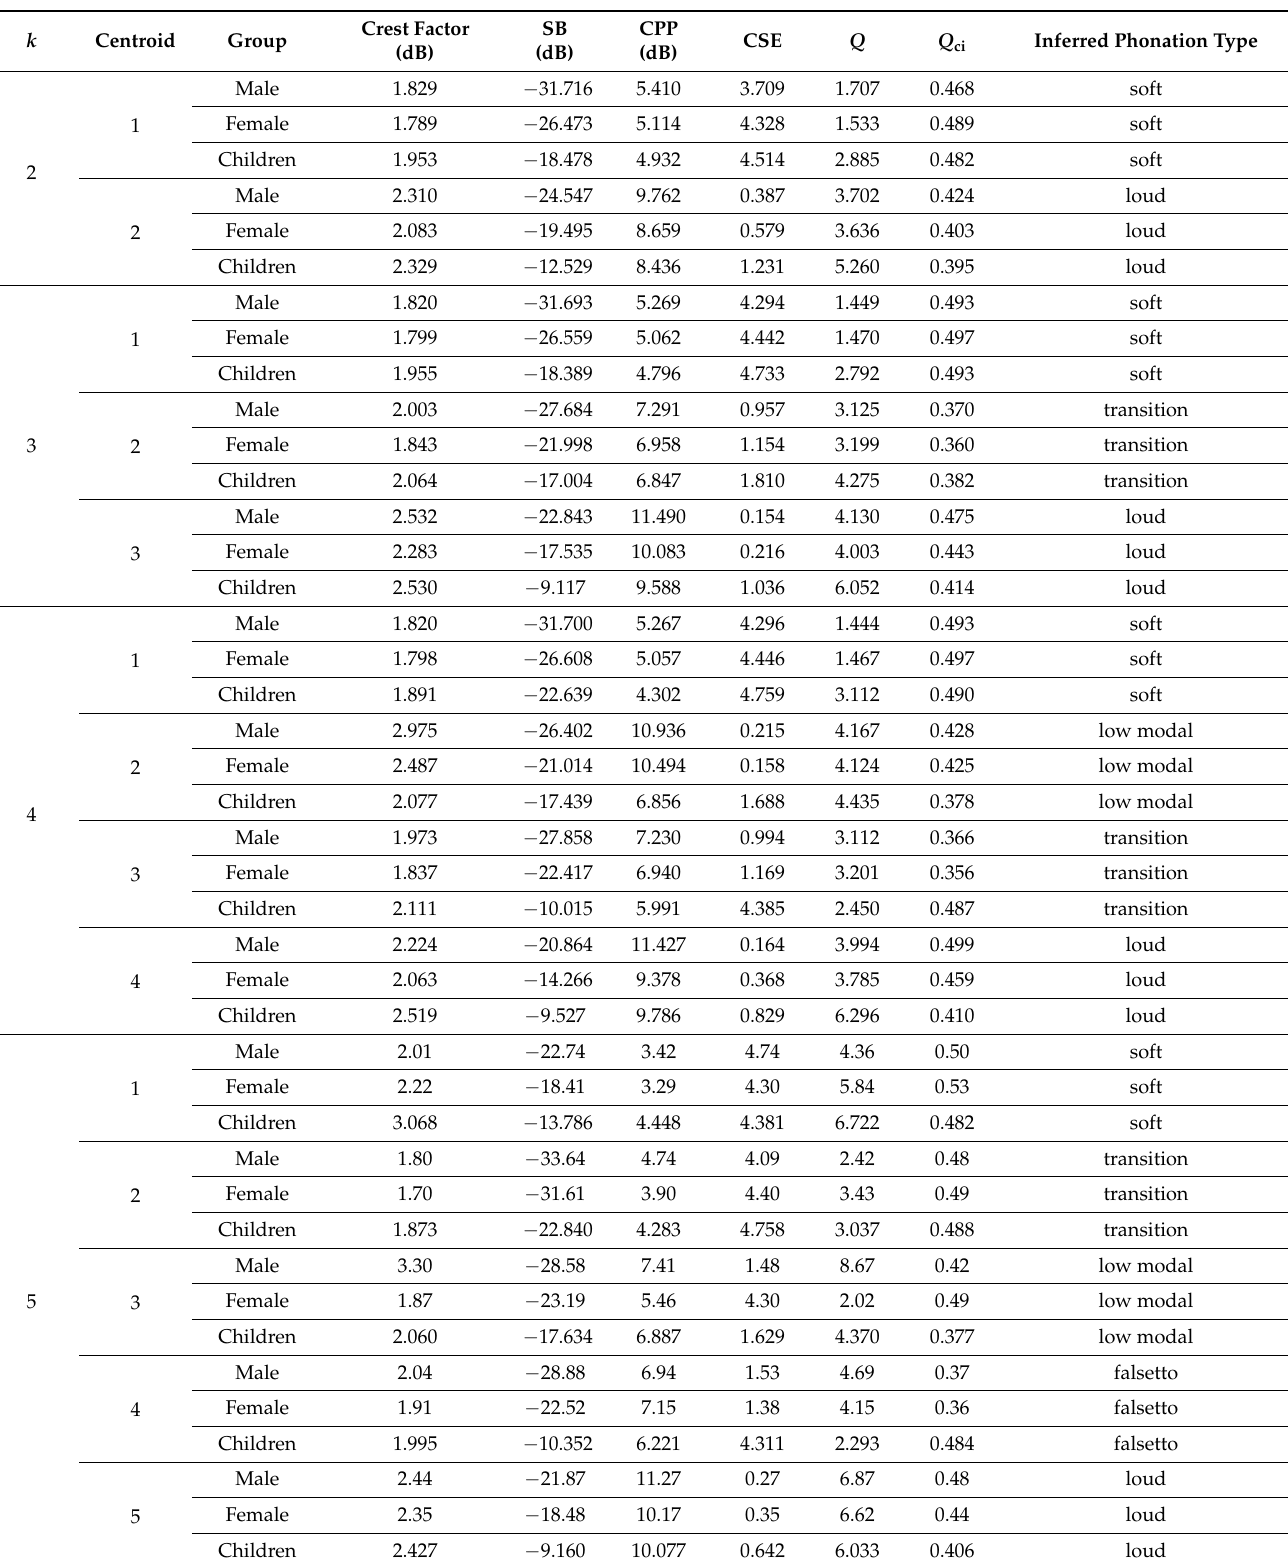
Table A4. Centroid values for k = 2 . . .